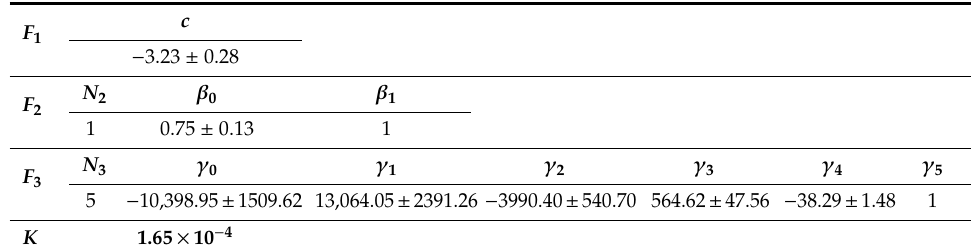
Table 2. Mean values of the parameters in Equation